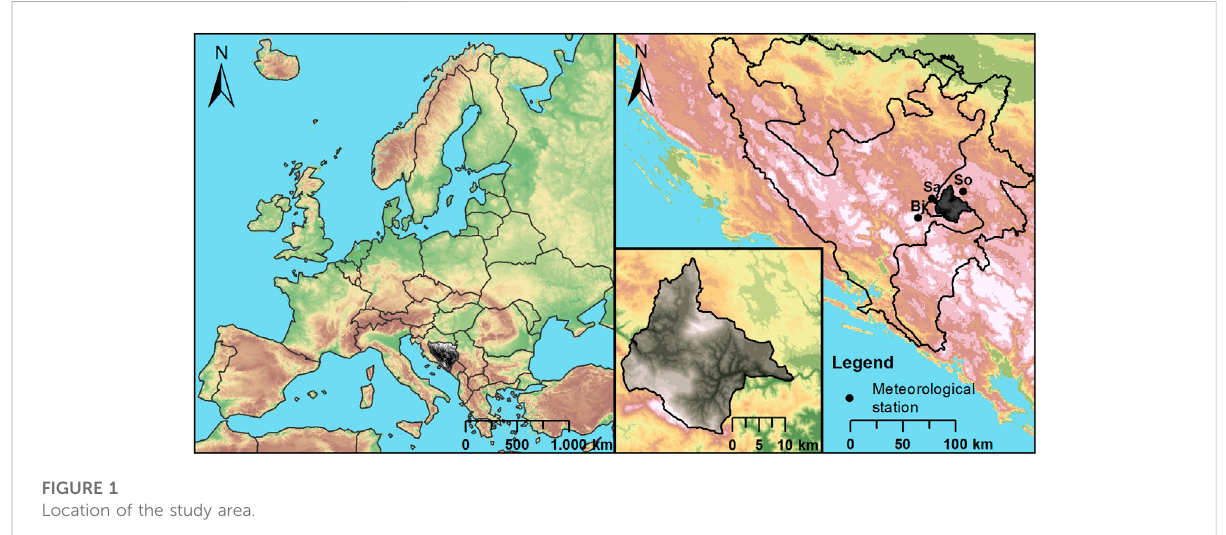
FIGURE 1 Location of the study